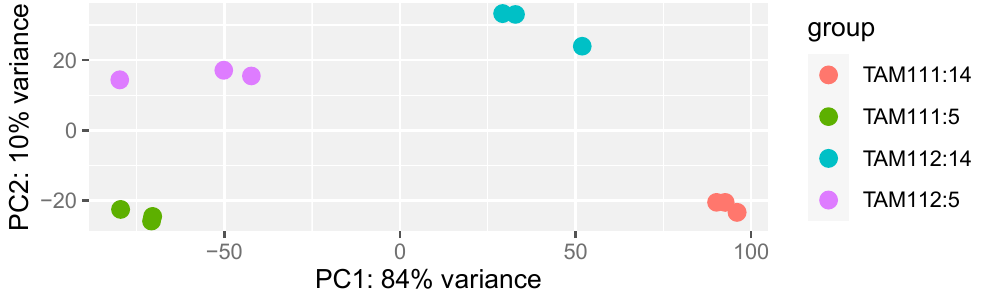
Figure 1. Principle component analysis plot of all samples. Red dots: 14 days after flowering (DAF) samples from TAM111, Green dots: 5 DAF samples from TAM111, teal dots: 14 DAF samples from TAM112, purple dots: 5 DAF samples from TAM112.